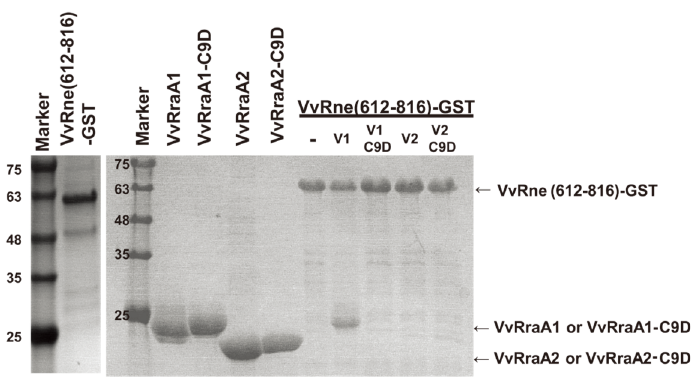
Fig 4. Interactions of VvRNase E with VvRraA proteins. Hexahistidine-tagged VvRraA1, VvRraA1-C9D, VvRraA2, VvRraA2-C9D, and the GST-fused VvRne (612–816 residues) were expressed and purified as described in the Methods section. The GST-fused VvRne protein was bound to GSH resin and incubated with VvRraA proteins and their C9D mutant proteins. Then, the proteins were eluted and the fractions were analyzed using SDS-PAGE. The protein bands were stained with Coomassie blue. Only VvRraA1 could tightly bind to